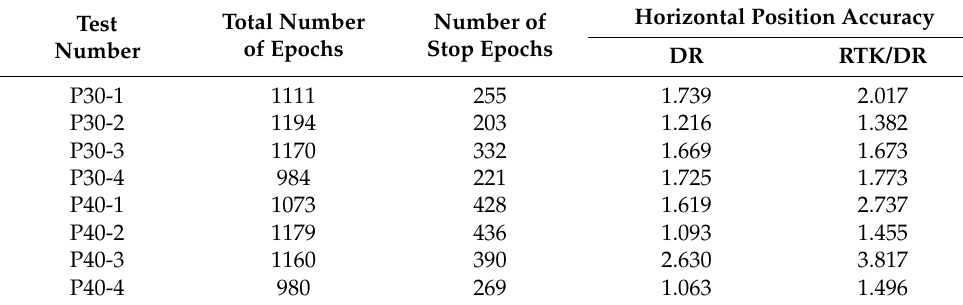
Table 5. Number of epochs for stop of measurement